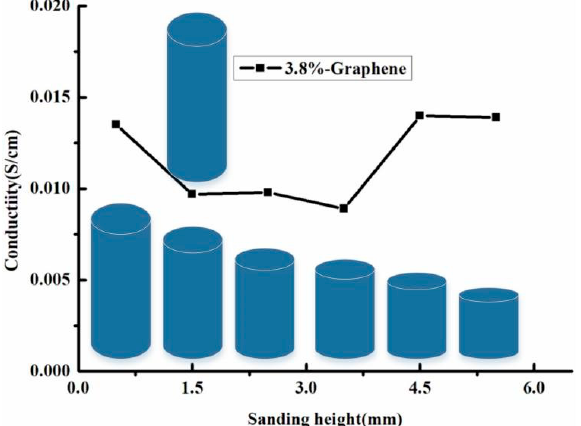
Figure 5. The electrical conductivity of Graphene/PEKK bar distribution on the different height.